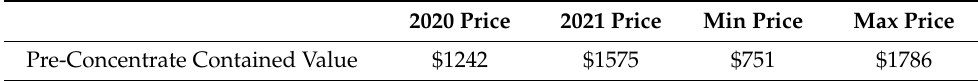
Table 5. Pre-concentrate contained value in